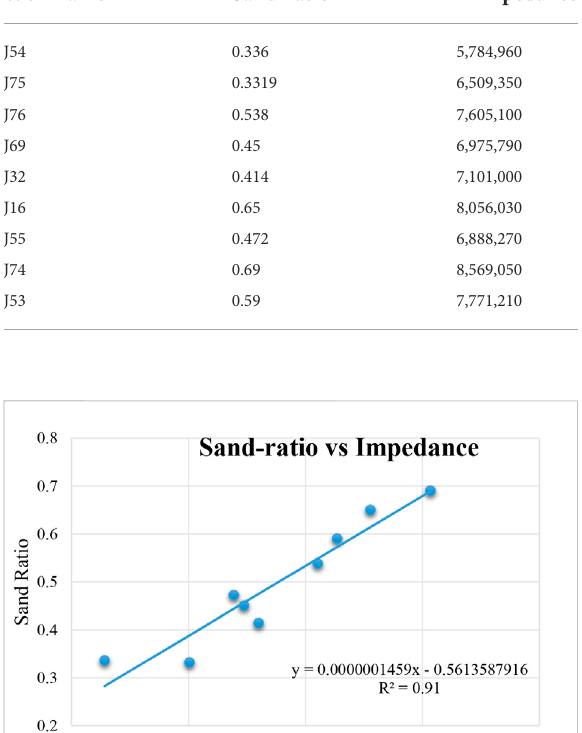
FIGURE 10 Sand-ratio maps of (A) T9c horizon & (B) T9d horizon. The highlighted well J54 is utilized in the study to assess the vertical distribution of